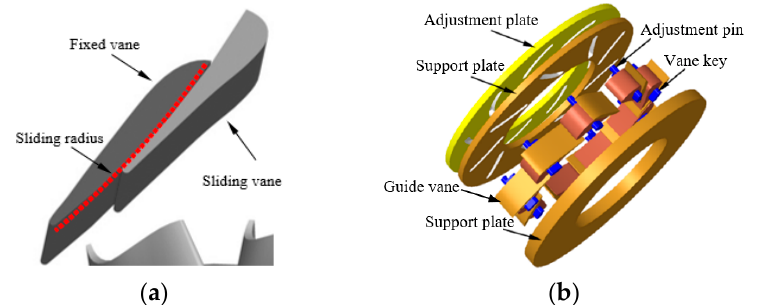
Figure 2. Geometry of the SSGV: ( a ) three-dimensional view of the SSGV; ( b ) actuator of the SSGV.